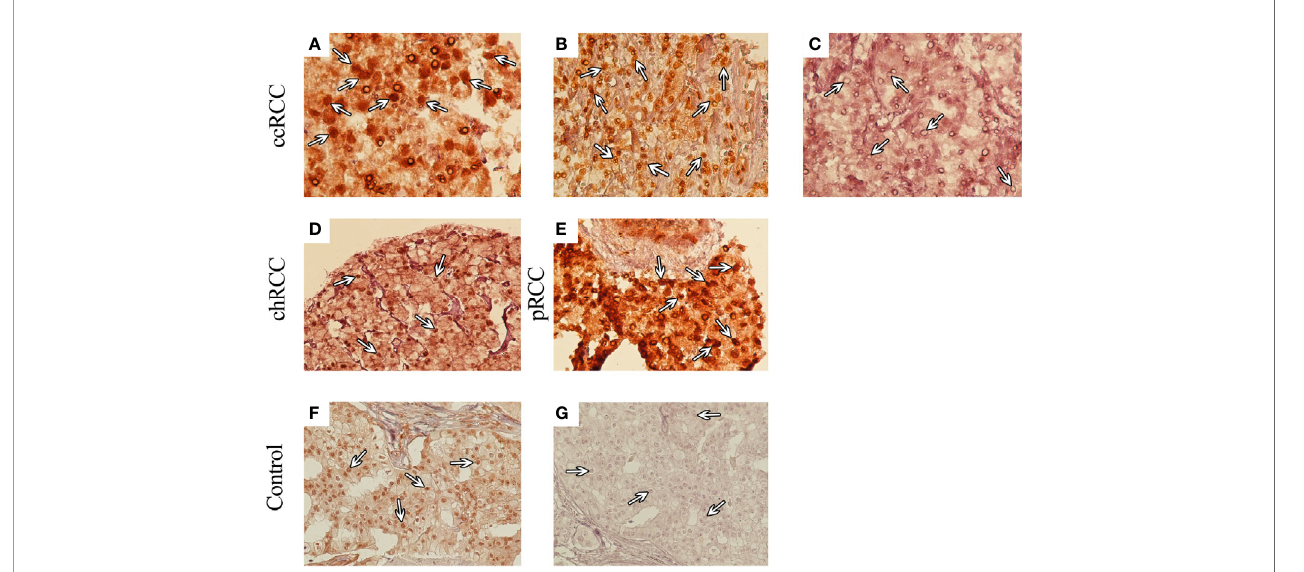
FIGURE 1 | Immunohistochemical (IHC) Analysis of Nuclear SMAD4 Expression in Different 707 Renal Cell Carcinoma (RCC) Samples. RCC samples expressed SMAD4 at various levels. SMAD4 expression in clear cell RCC at various levels: weak (A) , moderate (B) , and strong (C) . Moderate expression of SMAD4 in chromophobe RCC (D) and strong expression of SMAD4 in papillary RCC (E) . IHC staining of breast cancer tissue as positive (F) and negative (G) controls. (A – C) are presented with a magni fi cation of 400×, (D – G) are presented with a magni fi cation of